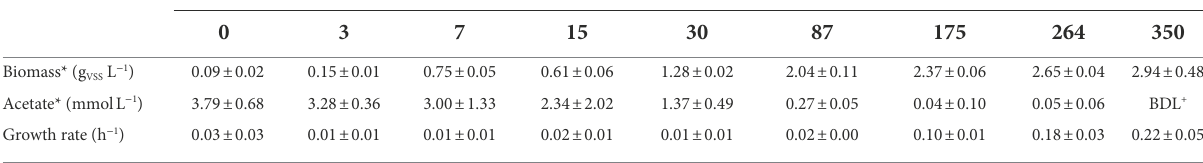
*Concentration measured at the end of the reaction phase. + BDL, below detection